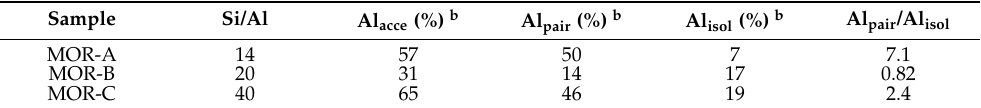
Table 1. Si/Al ratios of parent H-MOR hosts and corresponding portions of framework Al sites accessible to Na + /Co 2+ ion- exchanges a .